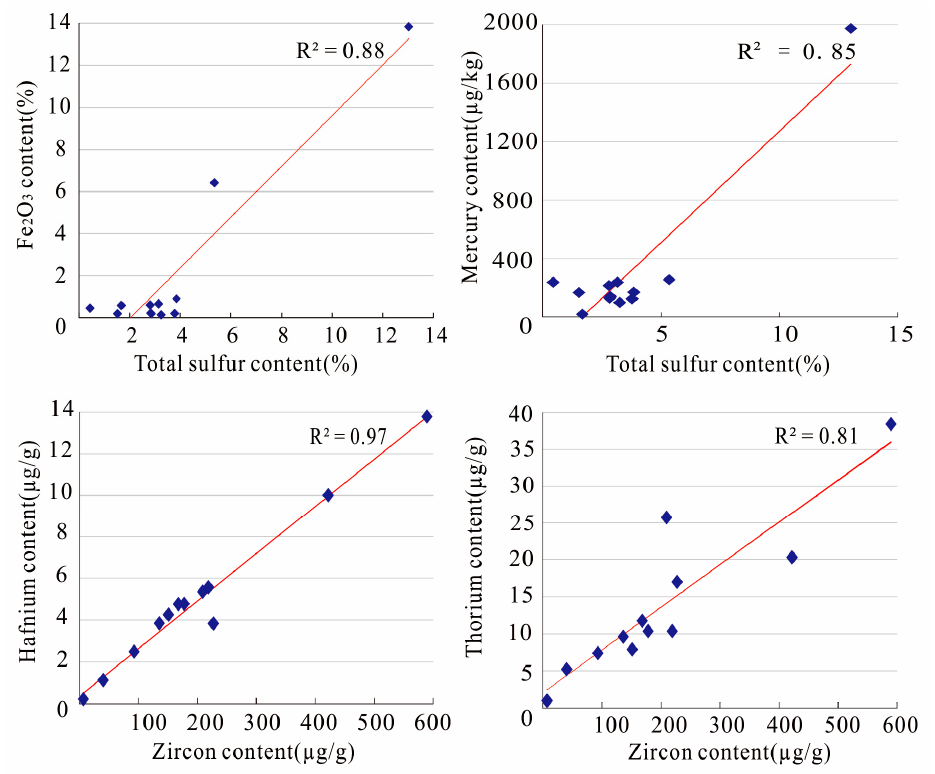
Figure 7. Correlation coefficients between two elements.